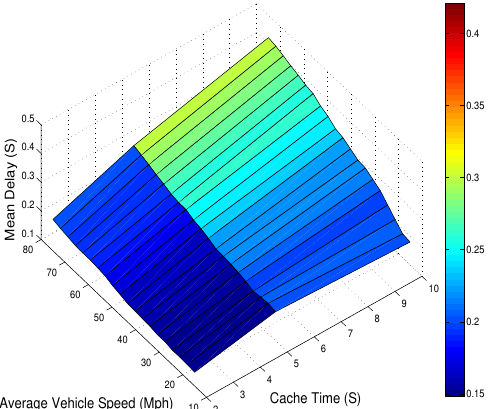
Figure 9. Average end-to-end delay vs. 2 s, 5 s, 10 s Cache Time and Average Vehicle Speed (Mph).